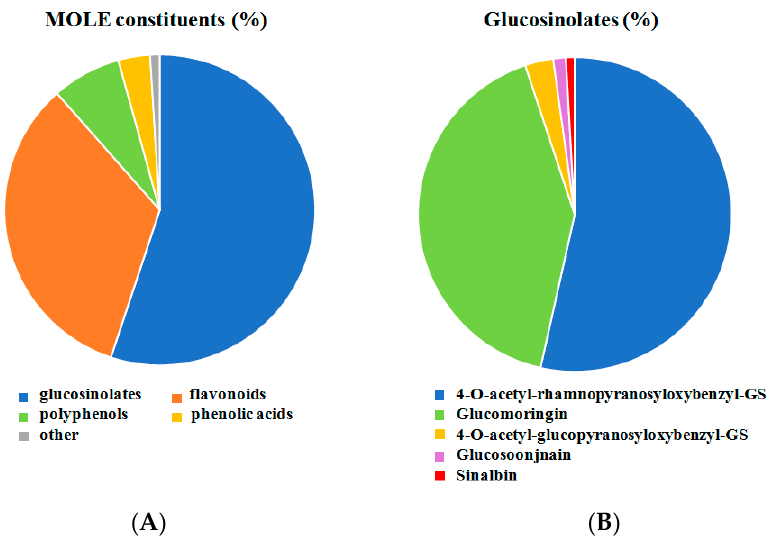
Figure 1. Relative amounts of constituents of MOLE. Metabolomic analysis was performed on MOLE working solution. Relative percent of different categories of compound was shown in panel ( A ). SWATH MS/MS spectrum of MOLE extract was performed for glucosinolates analysis. Relative percent were shown in panel ( B ).